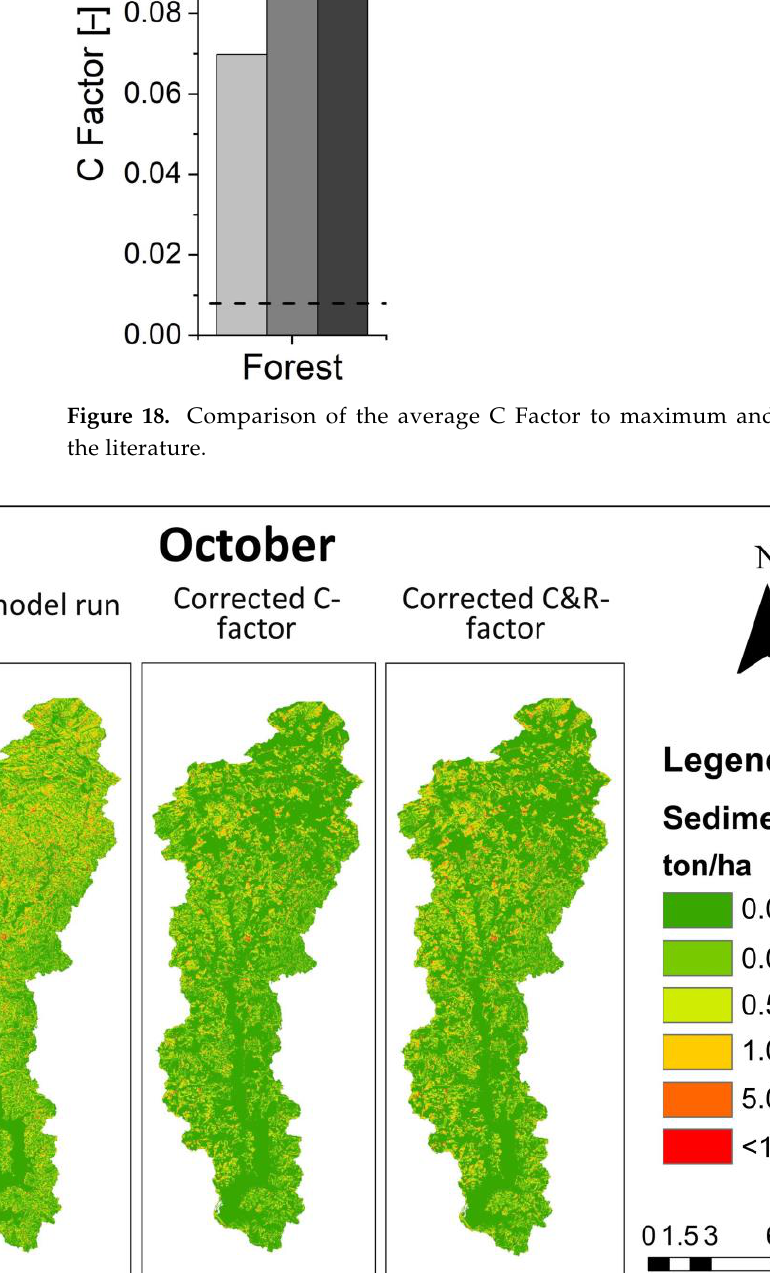
Figure 19. Final distribution of sediment input after C and R Factor correction.